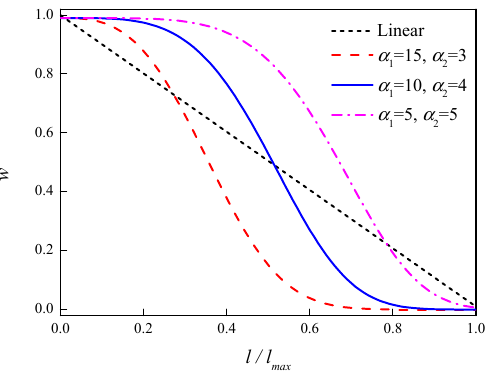
Figure 10. Comparison between linear w and nonlinear w with different parameter